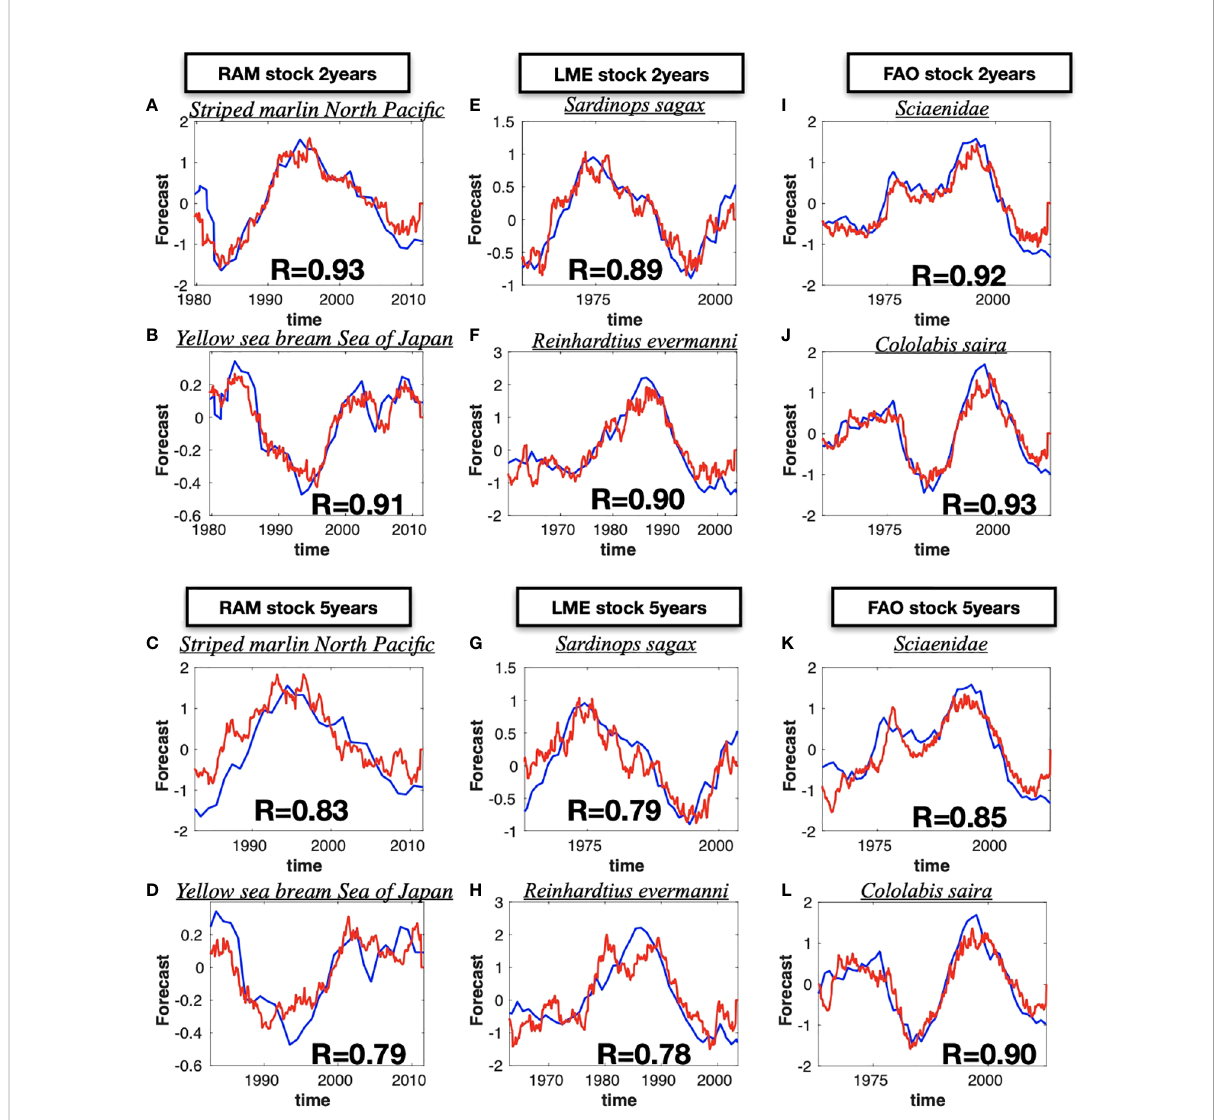
FIGURE 6 Selected single stock time series (blue lines) and the forecasted time series (red lines). The stock have been selected considering those that have the highest difference between forecasting LIM skill and the persistence. The 2-year lead forecast are shown for the RAM (A , B) , for LME (E , F) and for the FAO (I, J) . The same comparison are shown for the 5-year lead forecast in panels (C , D) for RAM, (G , H) for LME, and (K , L) for FAO. The name of the selected stock is displayed at the top of each